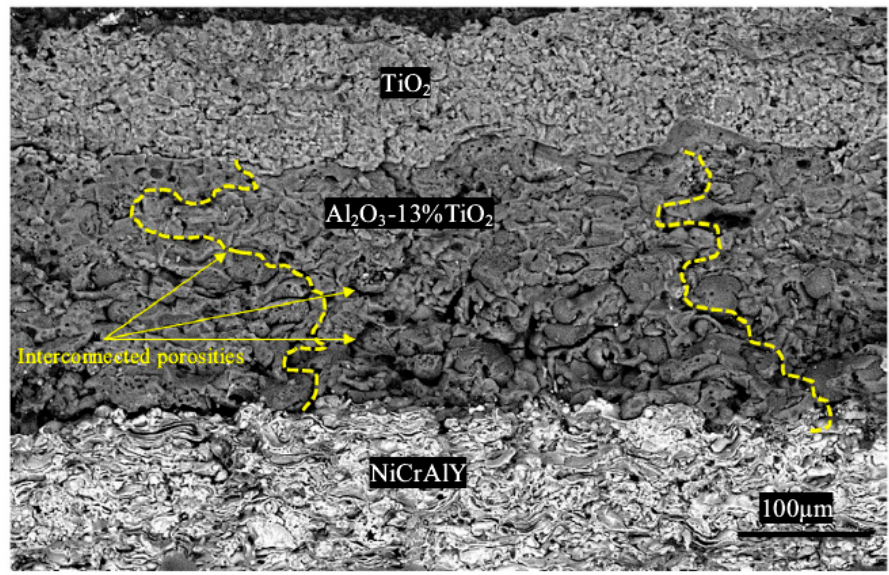
Figure 10. Fracture diagram of three-layer NiCrAlY / nano-Al 2 O 3 · 13%TiO 2 / nano-TiO 2 coating [64]. Reprinted with permission from [64]; 2015 Elsevier.